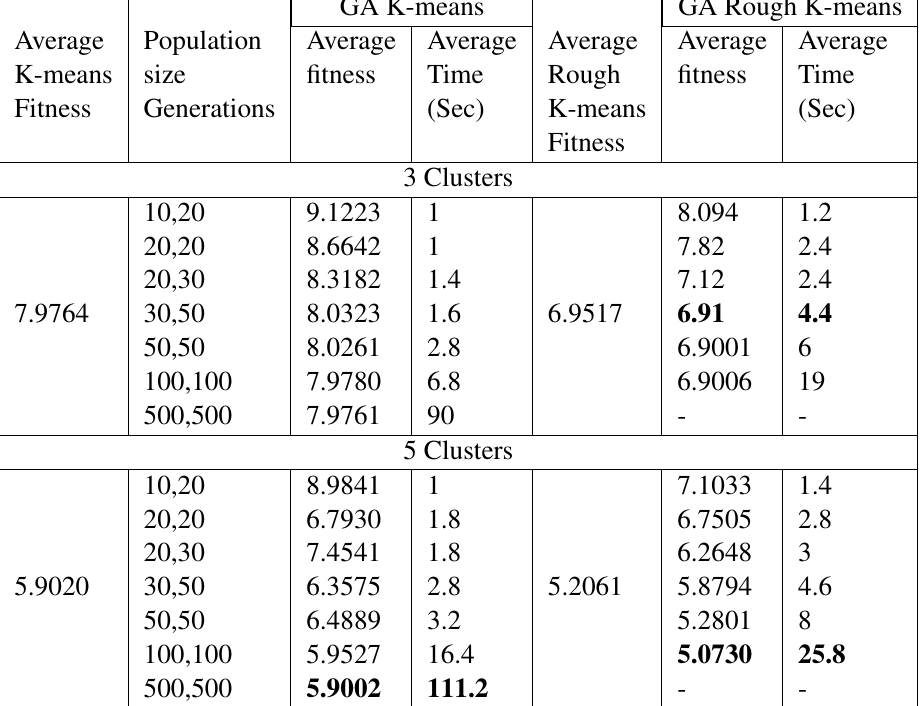
Table 3: Comparison between crisp and evolutionary algorithms for Library